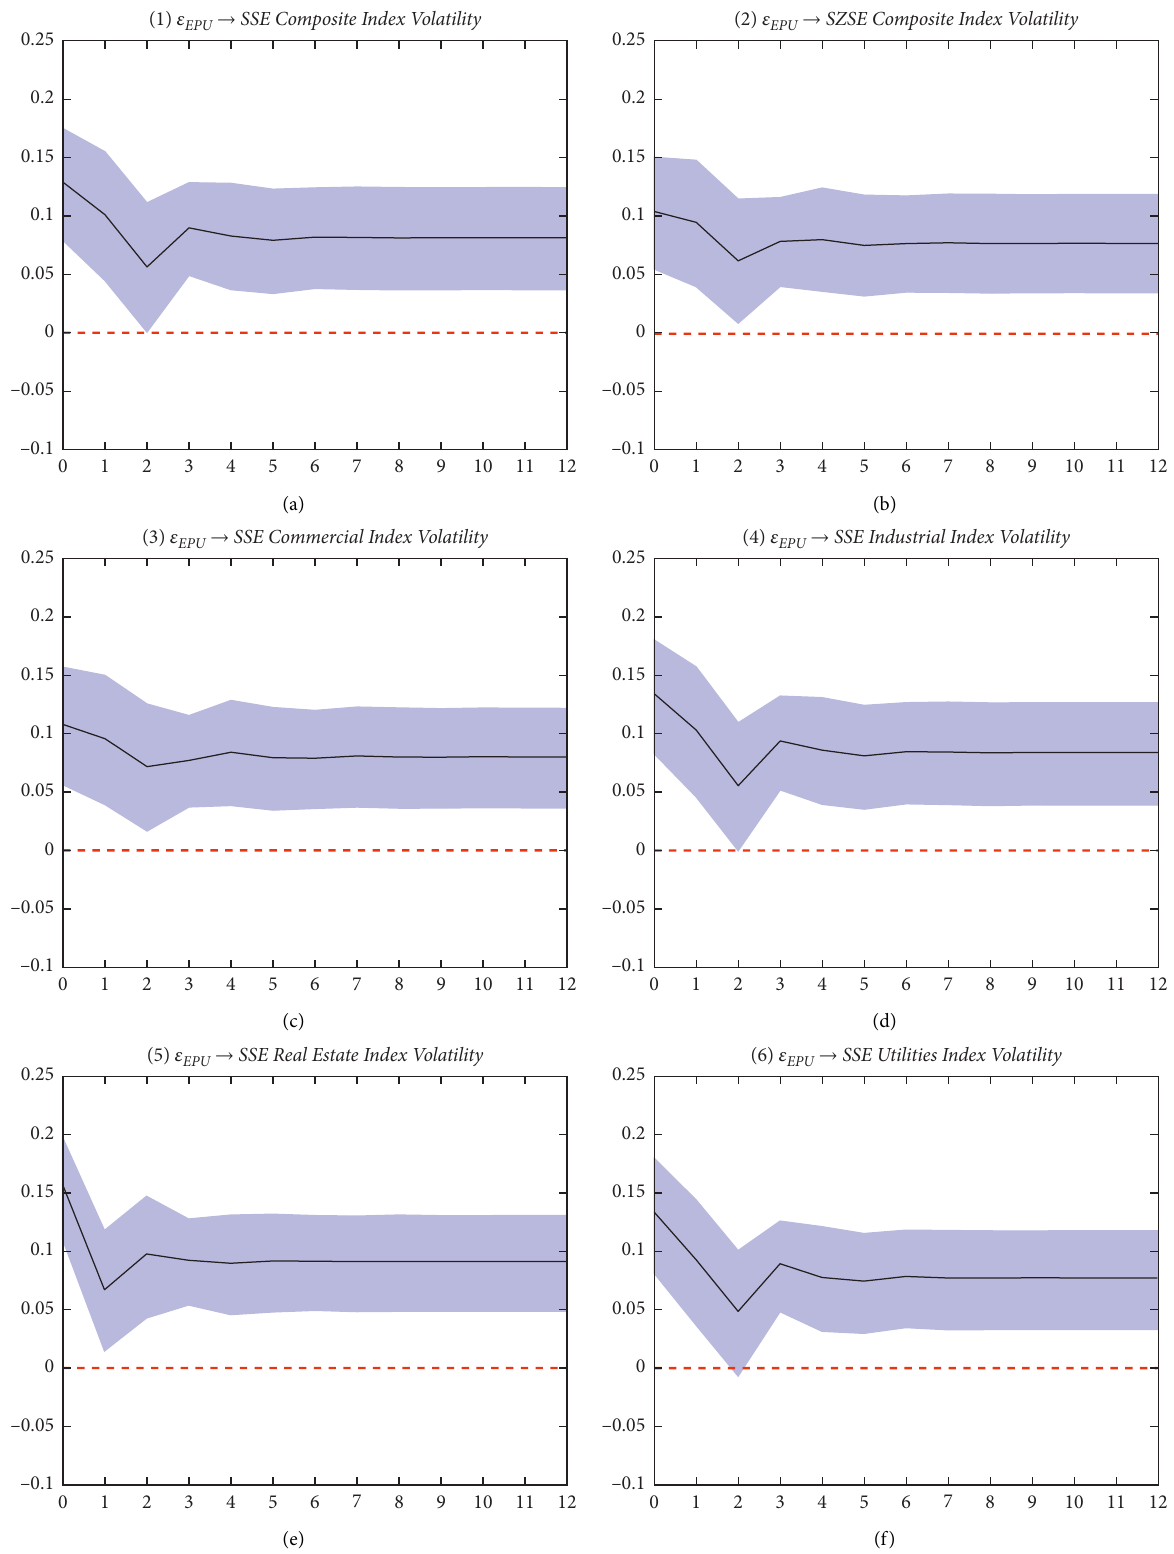
Figure 12: Cumulative impulse response of stock market volatility to EPU shocks. Notes: for robustness, we also estimate the SVAR models with lag order 2, inspired by the research of Huang and Luk [1]. The solid black lines represent the median impulse response. The light- colored region represents 68% of error bands. Each period is a